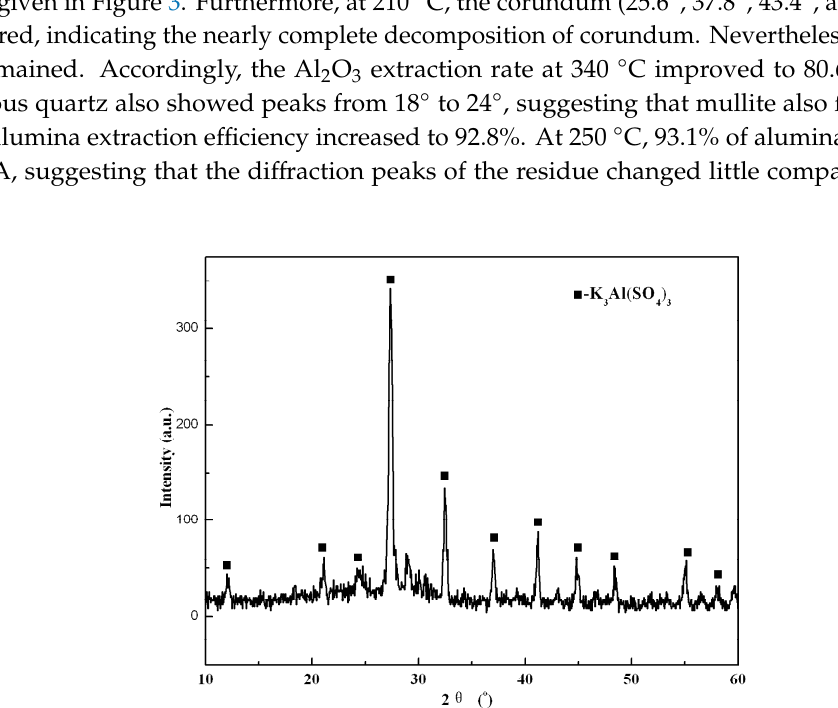
Figure 6. X-ray di ff raction (XRD) patterns of products calcined at 230 ◦ C with a KHSO 4 / Al 2 O 3 molar Figure 6. X-ray diffraction (XRD) patterns of products calcined at 230 °C with a KHSO 4 /Al 2 O 3 molar ratio of seven for 3 h. ratio of seven for 3 h.